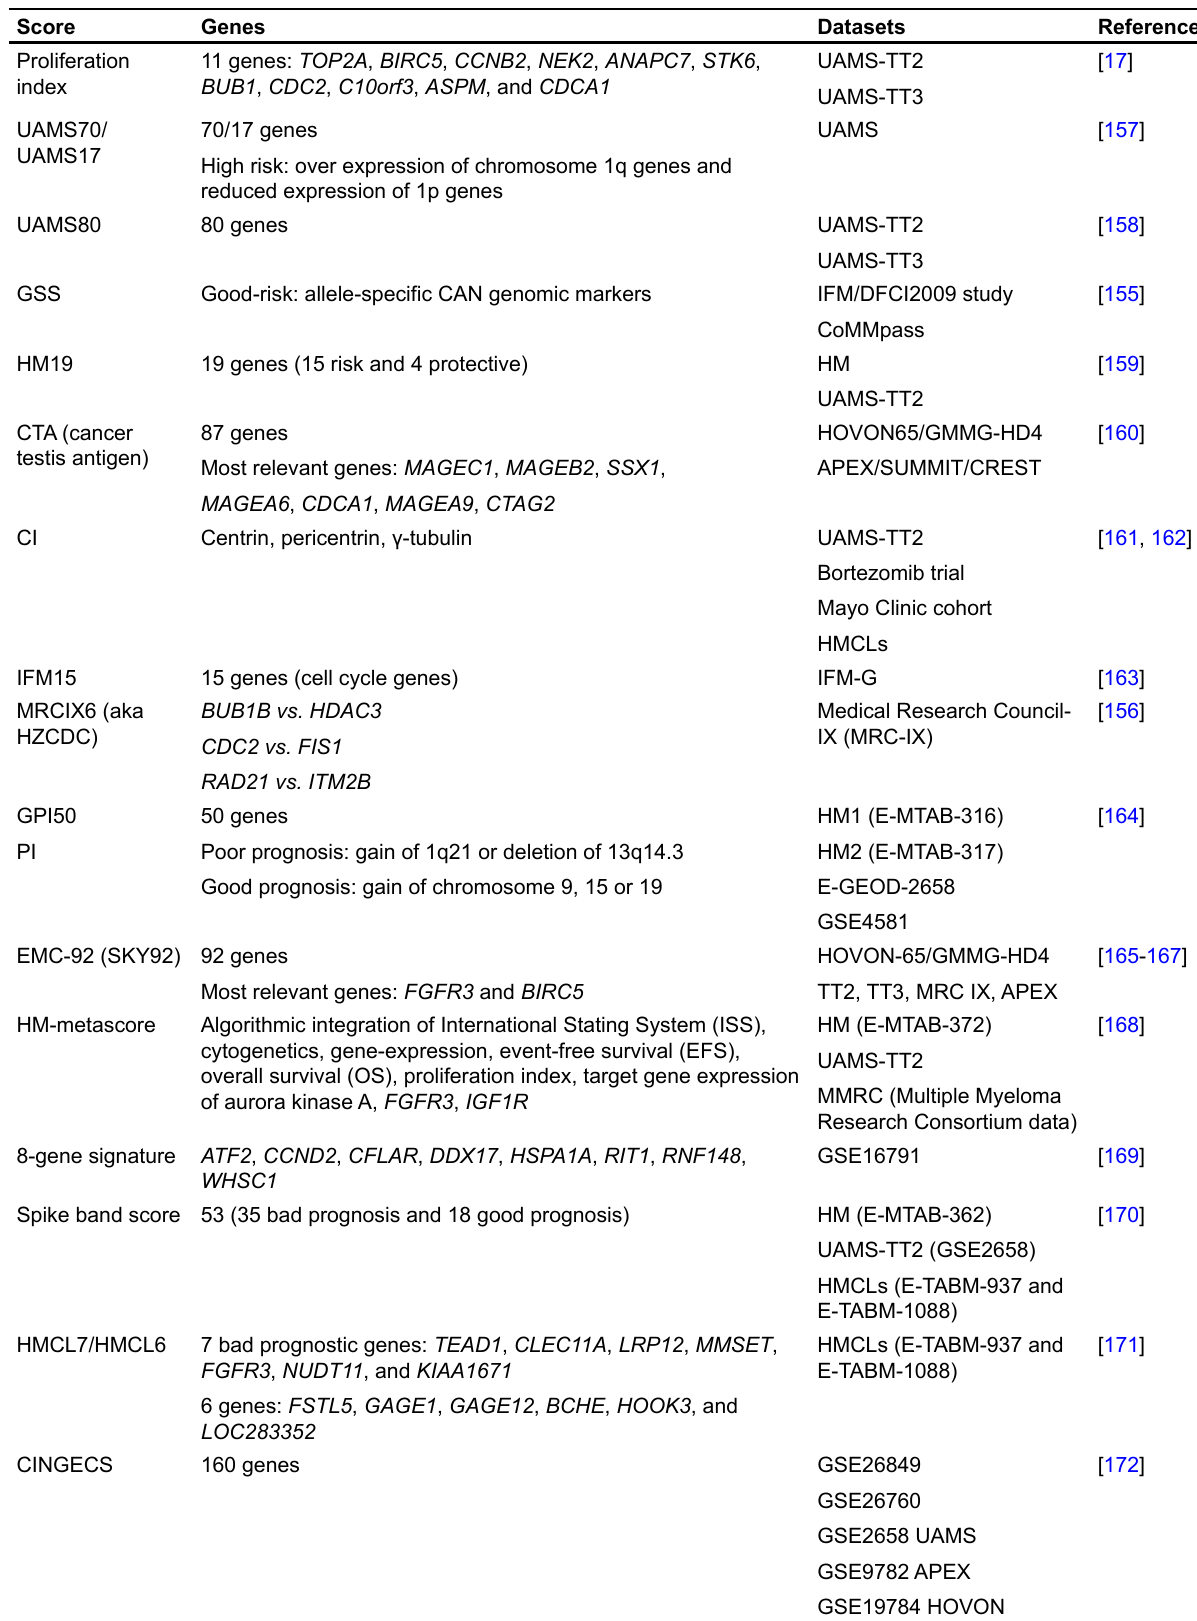
Algorithmic integration of International Stating System (ISS), cytogenetics, gene-expression, event-free survival